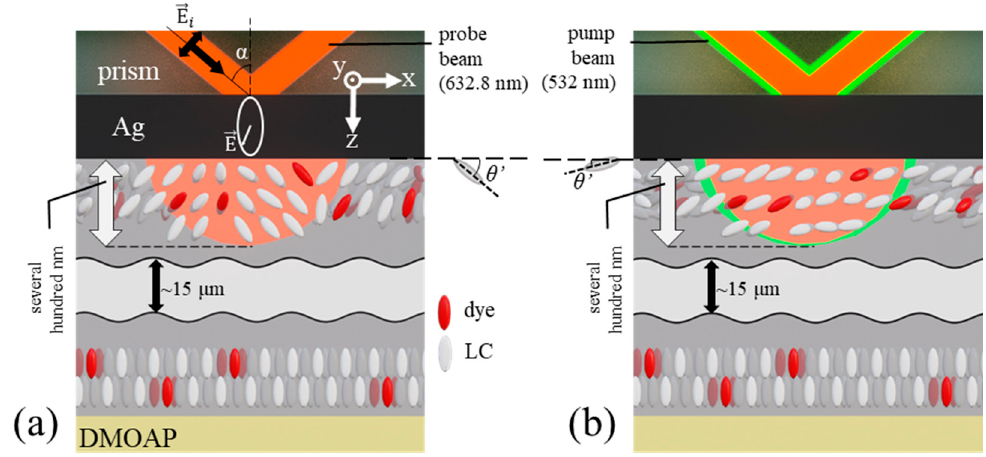
Figure 2. Orientation of LC molecules near the Ag surface of the prism and the DMOAP surface in the ADDLC cell ( a ) without and ( b ) with the irradiation of green pump light.